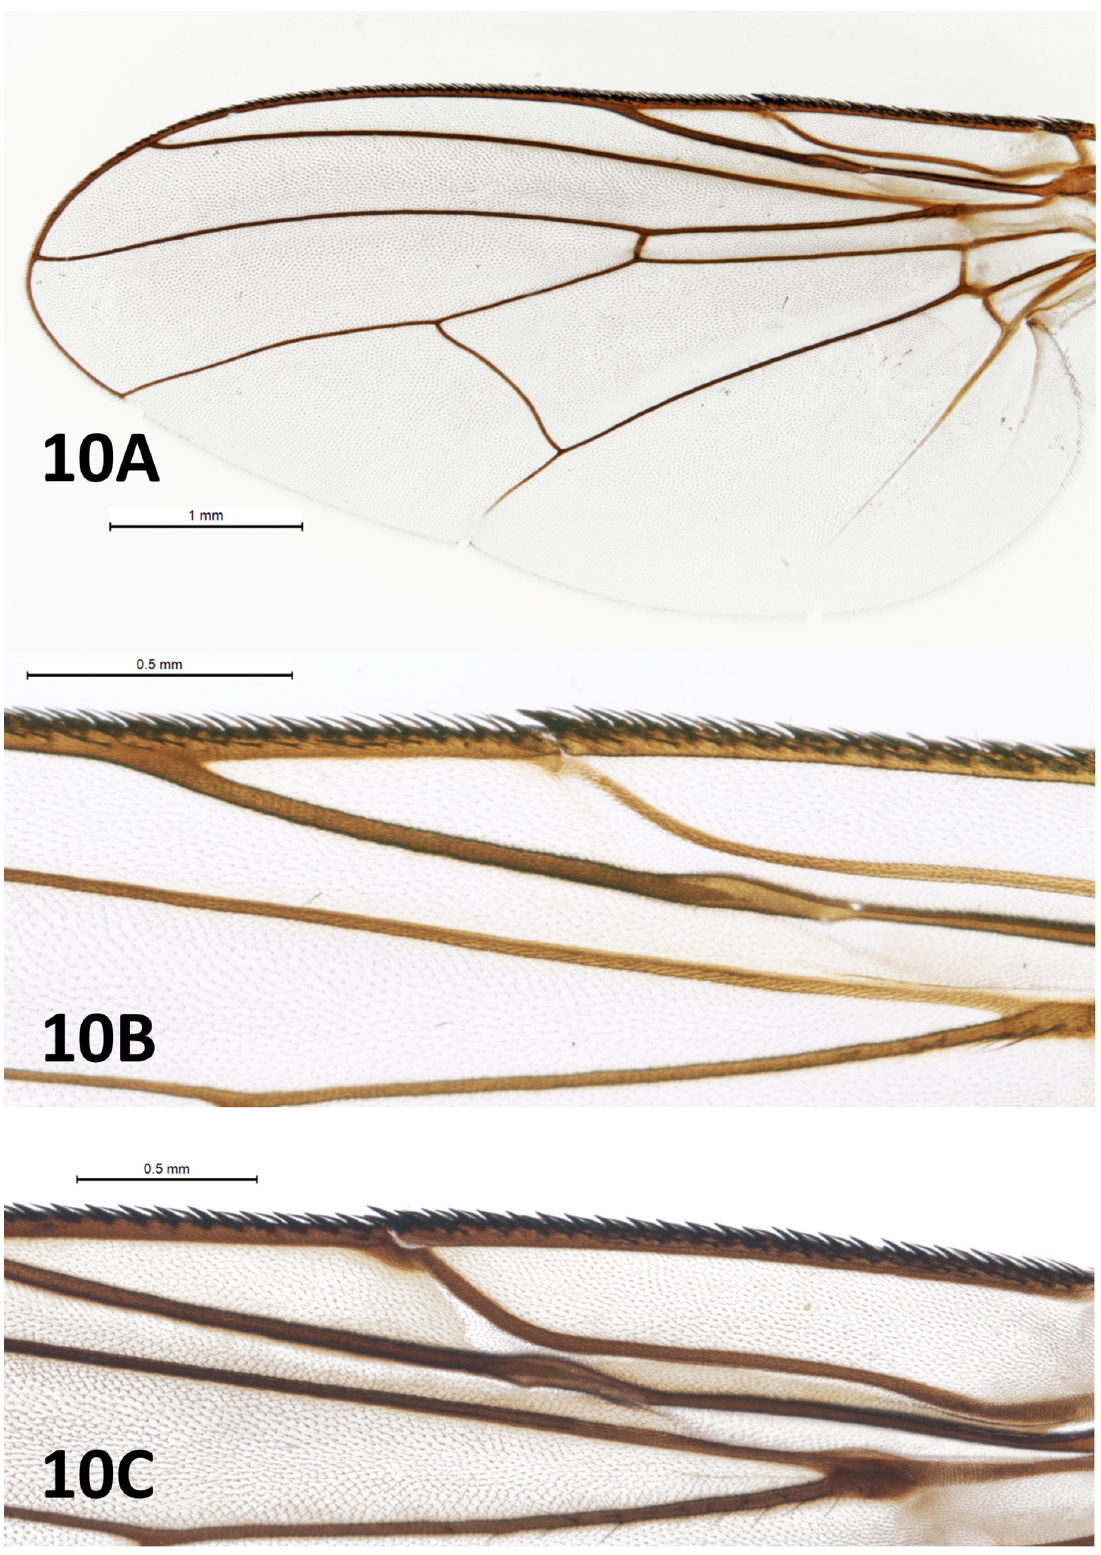
Fig. 10. ♀♀ of Polietes Rondani, 1866. A . P . domitor (Harris, 1780), wing, ventral view. B . Same, detail of wing showing CS1‒2, ventral view. C . P . lardarius (Fabricius, 1781), detail of wing showing CS1‒2, ventral